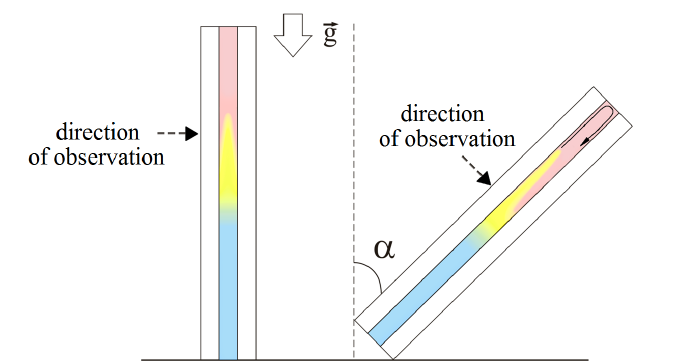
Figure 4. Schematic presentation of the slab reactor illustrating the effect of its inclination on the dynamics of the reaction zone (marked by